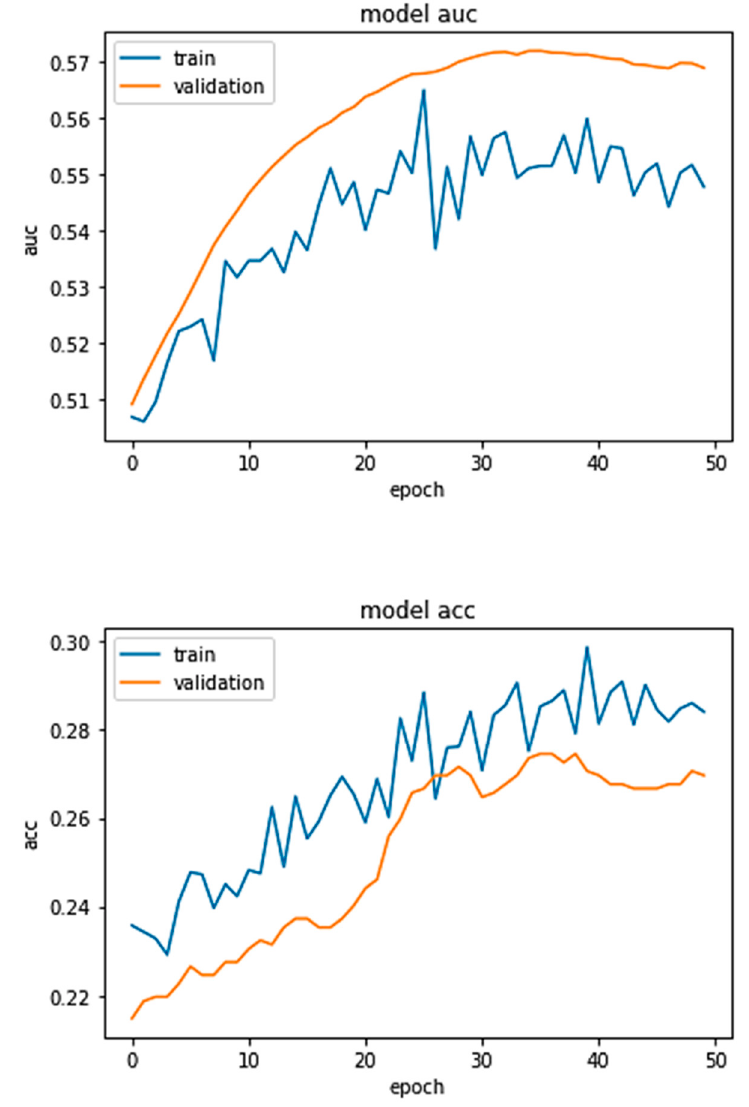
Figure 3. DRL Approach Accuracy and AUC.